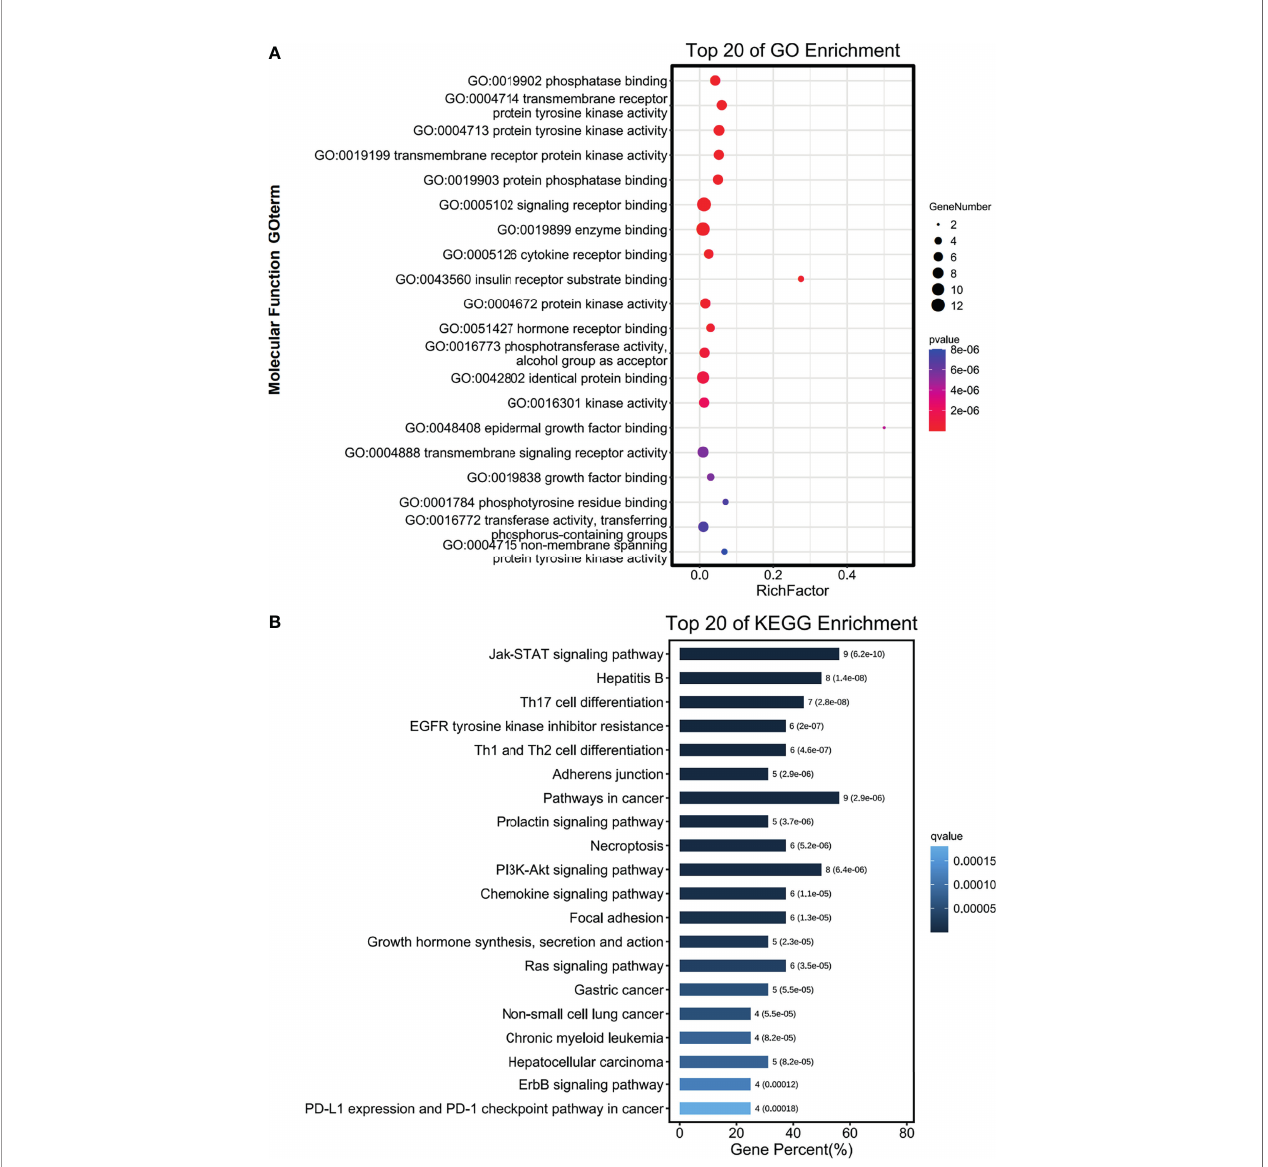
FIGURE 10 | Functions of the genes signi fi cantly associated with PTPN2 . (A, B) The functions of common genes in PTPN2 PPI network and PTPN2 correlated genes were predicted by the analysis of gene ontology (GO) (A) and Kyoto Encyclopedia of Genes and Genomes (KEGG) (B)